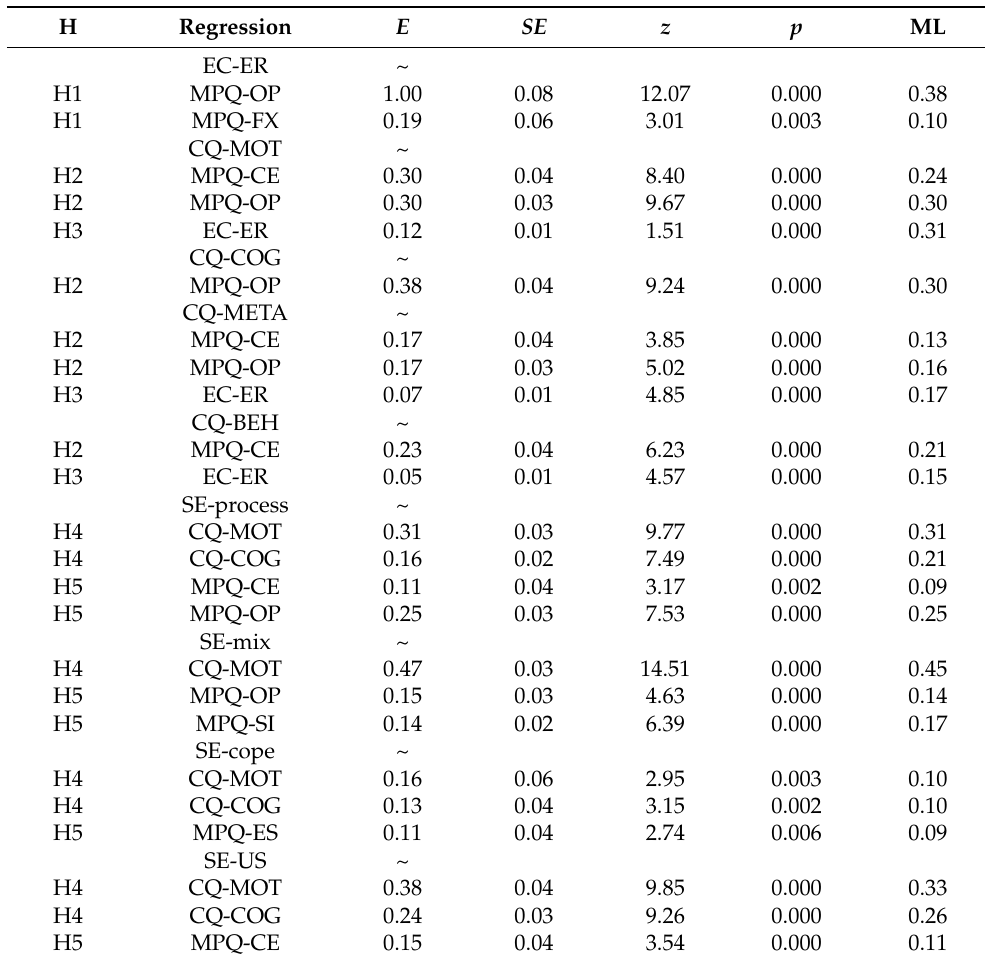
Table 4. Regressions from Model